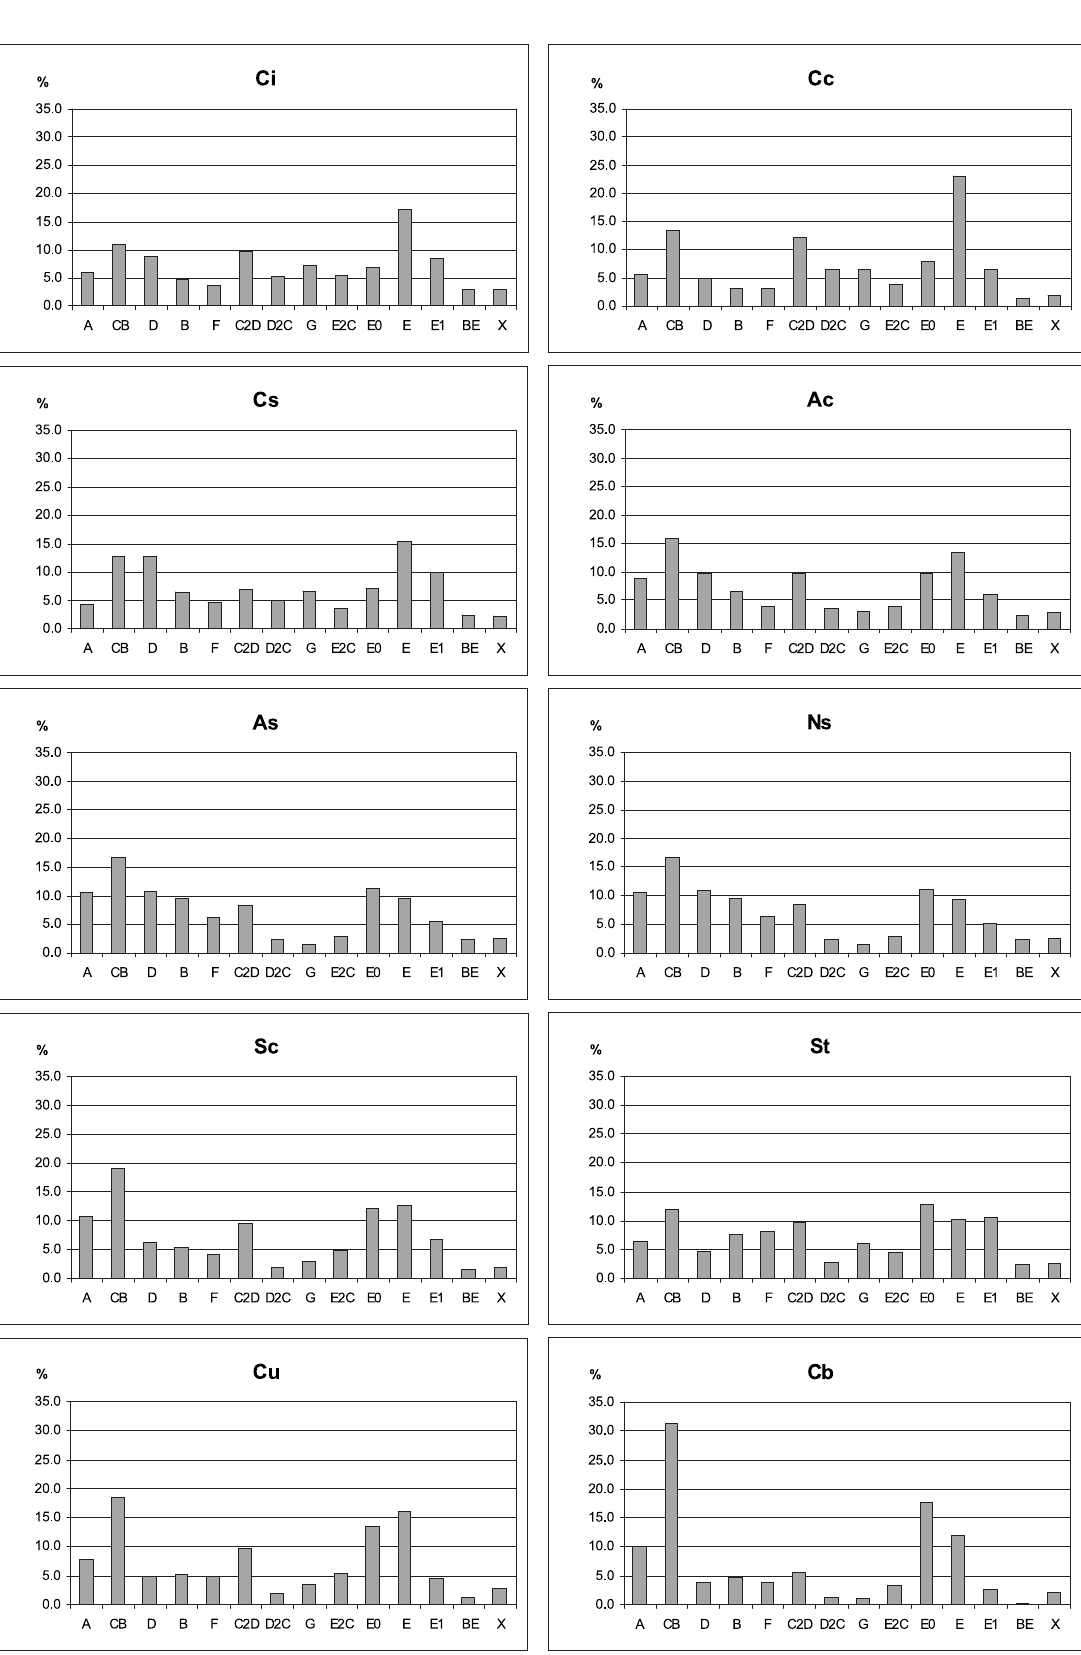
Fig. 4. Frequency of occurrence of cloud cover depending on the given atmospheric circulation type according to Osuchow- ska-Klein classification in Poznań